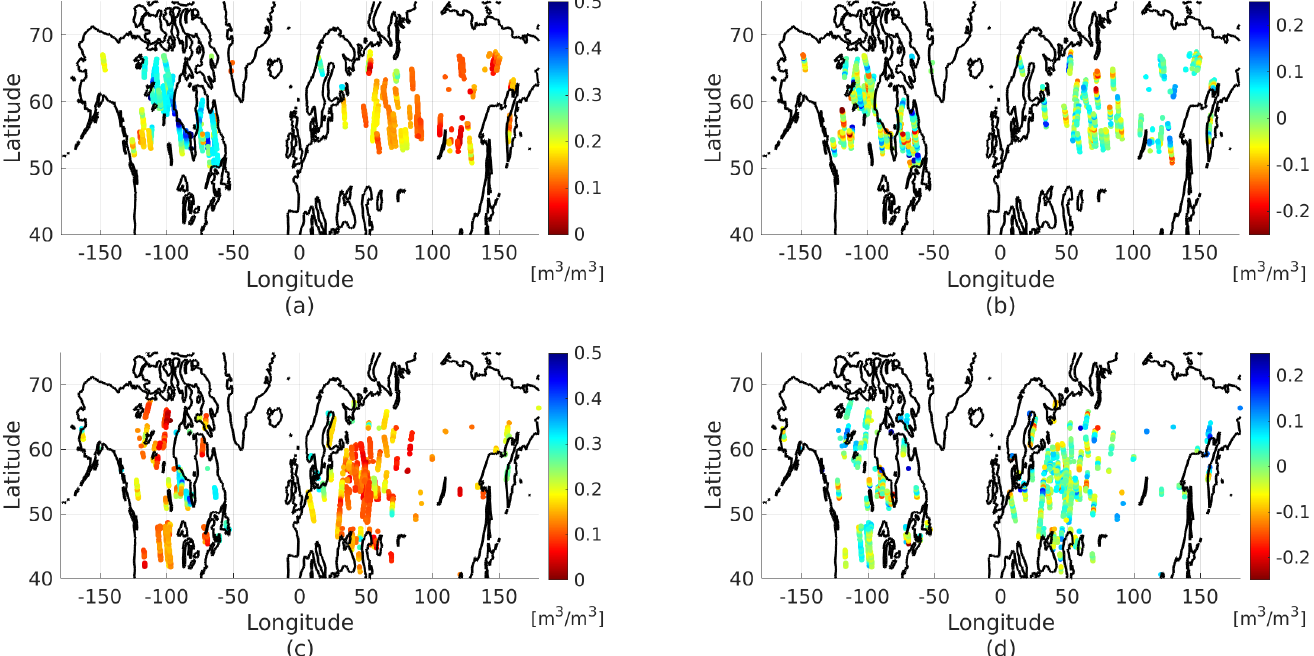
Figure 12. ( a , c ) Combined MWR and GNSS-R SM estimations corresponding to N = 20. ( b – d ) Error with respect to the collocated SMOS SM product. The map presents the measurements collected by FMPL-2 from ( a , b ) 1–31 October 2020 and from 1 November to 4 December 2020. Only reflections collocated with SMOS SM data are